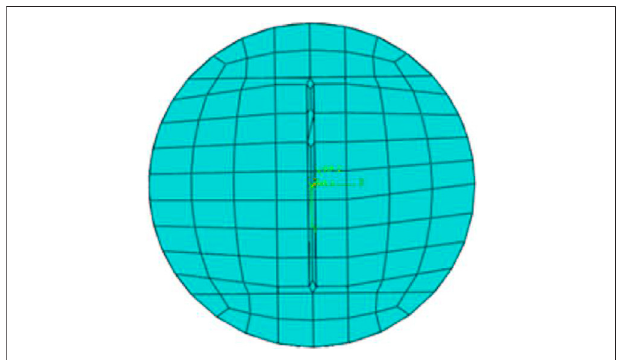
FIGURE 2 | Diagram of transverse meshing for GRS composite